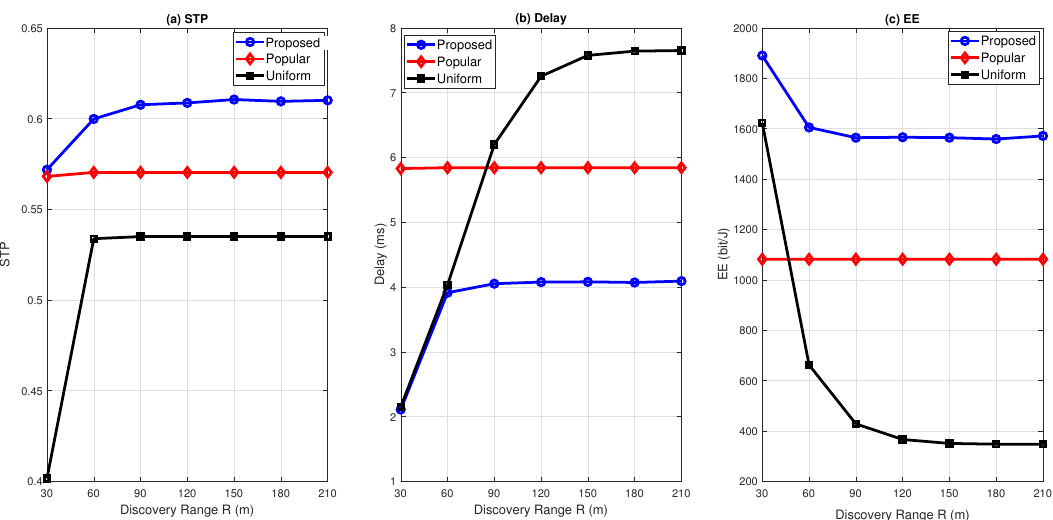
Figure 2. STP, delay, and EE versus the discovery range when M = 20 contents, λ U = 0.1 users/m 2 , λ F = 0.01 F-APs/m 2 , λ C = 0.0001 C-APs/m 2 , γ = 0.8, α = 4, P F = 30 dBm, P C = 40 dBm, P s = 37 dBm, ρ = 15.13, W F = 100 MHz, W C = 500 MHz, T = 1 ms, and τ = 0.1 Mbps.